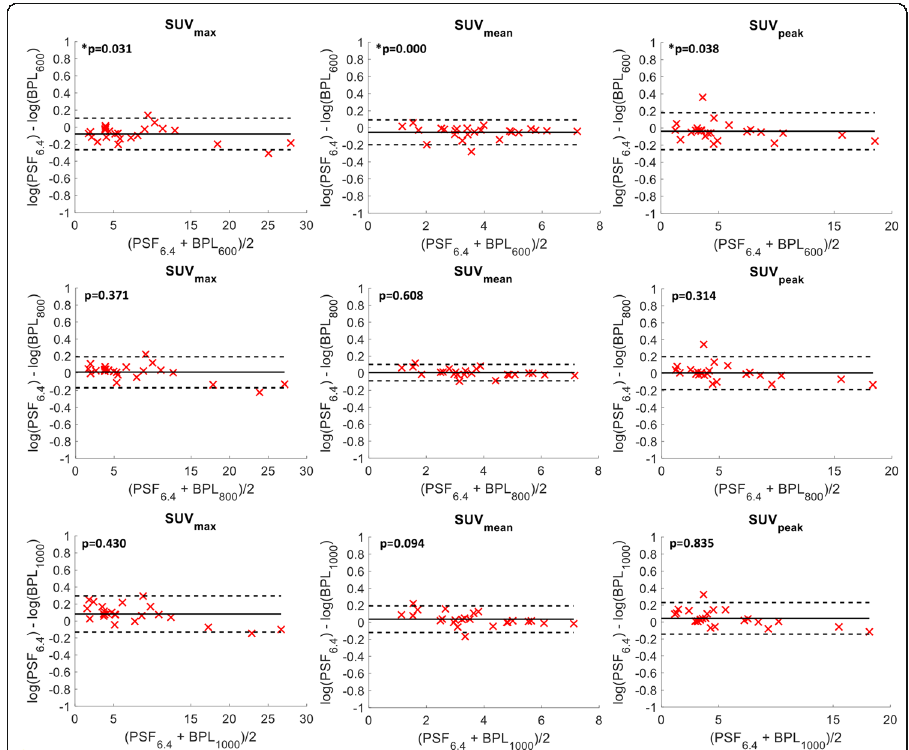
Fig. 10 Bland-Altman plots for SUV max (left column), SUV mean (middle column) and SUV peak (right column) of all 22 lesions with the black solid line being the average difference of the log-transformed SUVs between PSF 6.4 and BPL 600 (first row), BPL 800 (middle row) and BPL 1000 (bottom row) and the dashed lines 1.96 x the standard deviation. The p value from the paired t test is also quoted on each figure with *